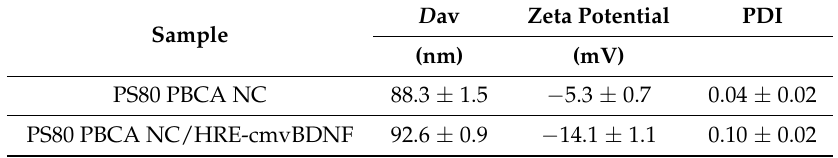
Table 1. Average diameter ( D av), zeta potential and polydispersity index (PDI) of the nanocarriers. Sample